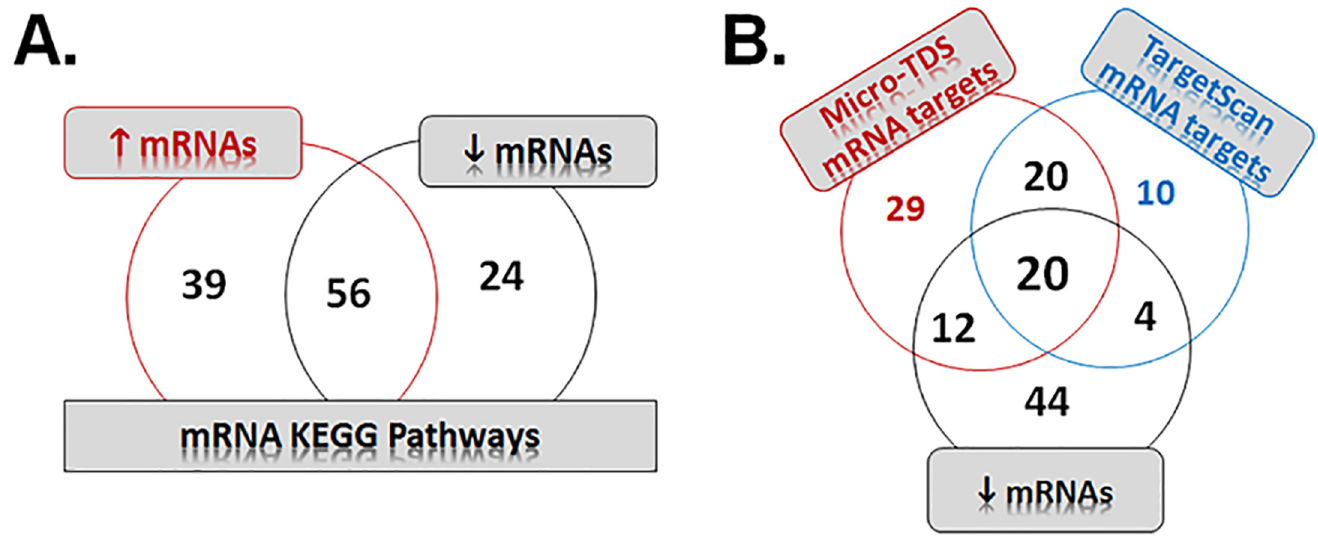
Fig 4. KEGG pathway enrichment analysis of dysregulated genes and miRNA-mRNA target pairs in the MWCNT-exposed workers. Venn diagrams showing common and unique enriched pathways of (A) up- and down-regulated mRNAs KEGG pathways, and (D) down-regulated mRNAs and miRNA- mRNAs targets identified using micro-TDS and TargetScan algorithms of